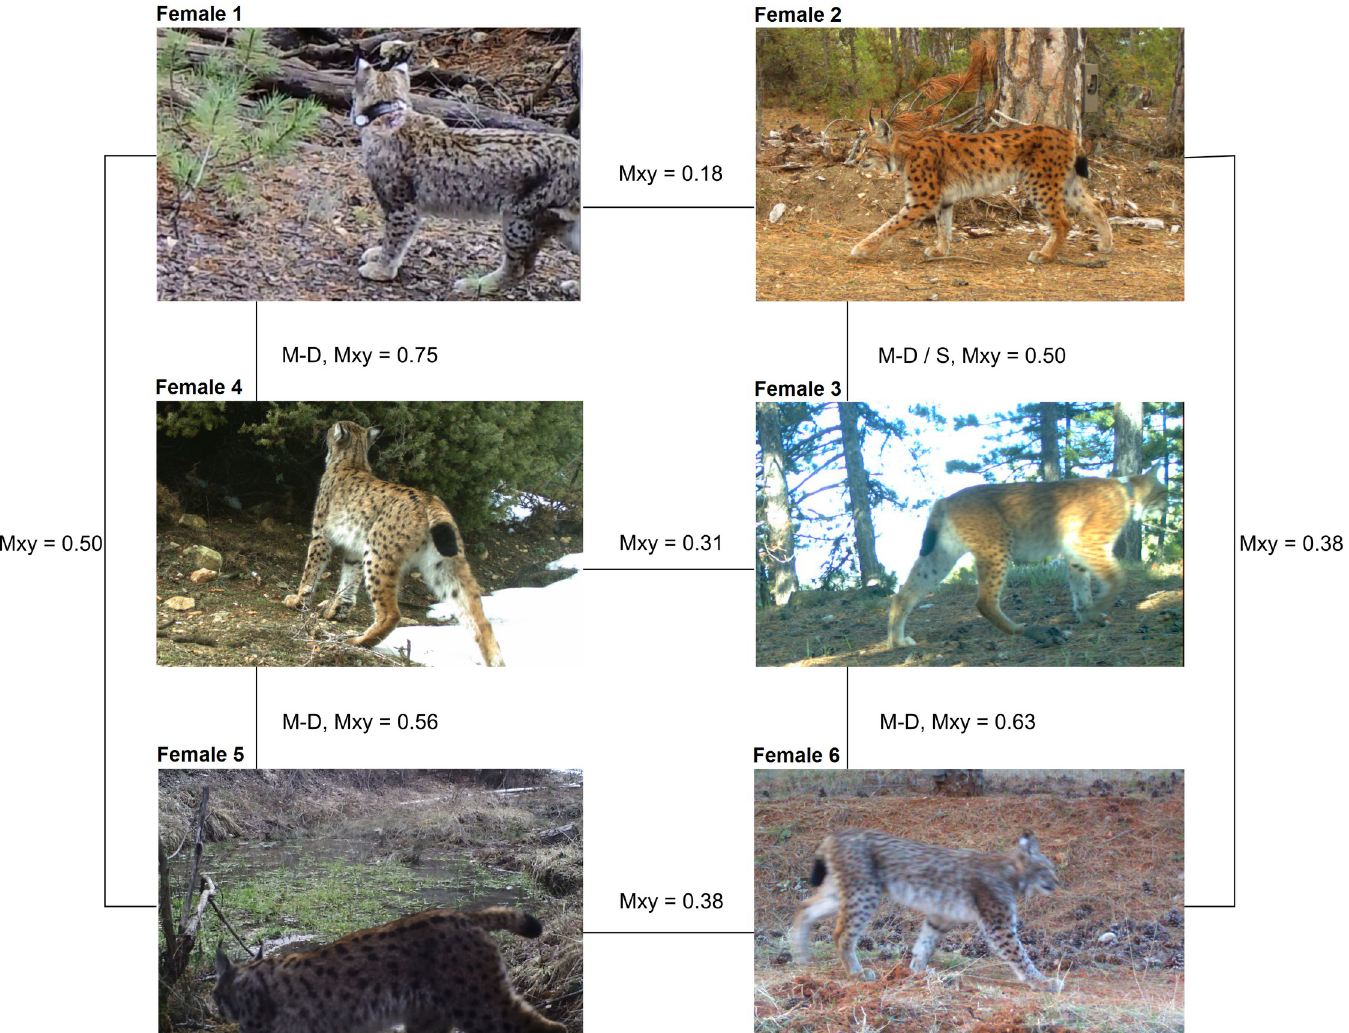
Fig 5. Coat patterns and M relatedness values of territorial (No 1–5) and subadult (No 6) female lynx in NW Anatolia. Mother–Daughter (M-D), Mother– xy Daughter or Siblings (M-D / S).